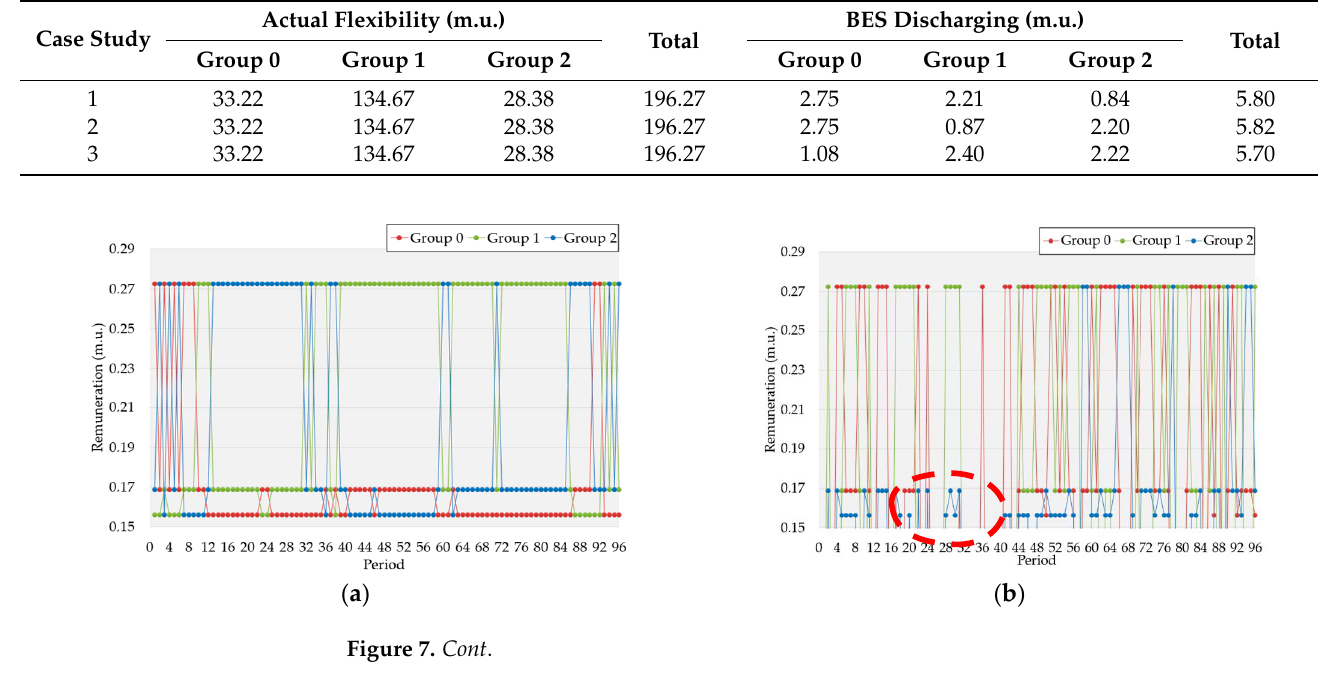
Table 5. Total remuneration according to clustering method.